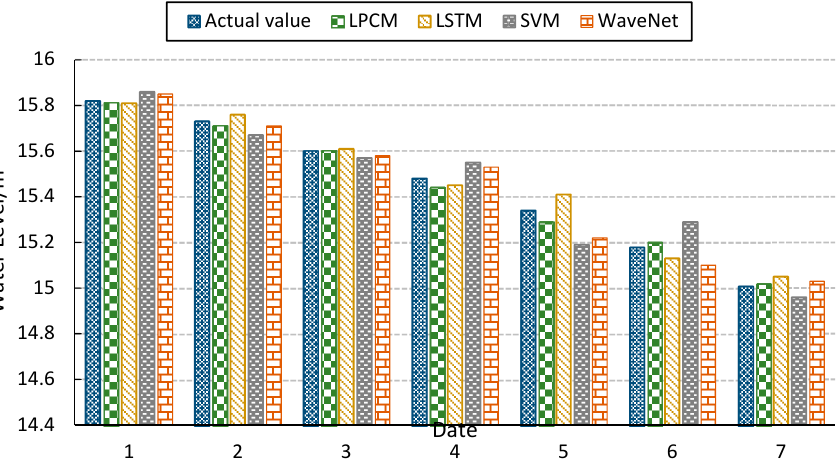
Figure 11. Predicted value of different models.